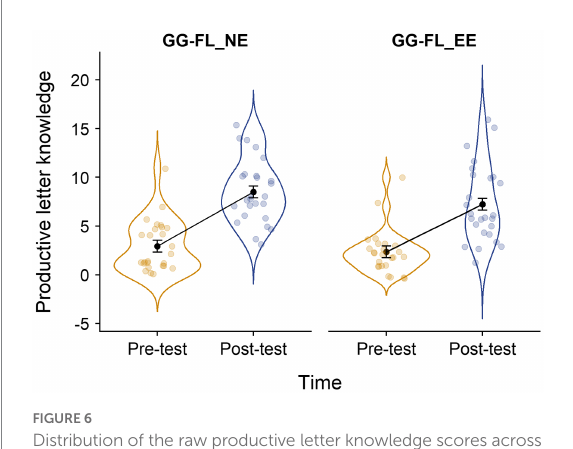
FIGURE 6 Distribution of the raw productive letter knowledge scores across groups and timepoints. LK, letter knowledge; GG-FL_EE, GraphoGame Flemish + envelope enhancement group; and GG-FL_NE, GraphoGame Flemish + non-enhanced group. Black dots and error bars represent the model estimates and their standard errors,